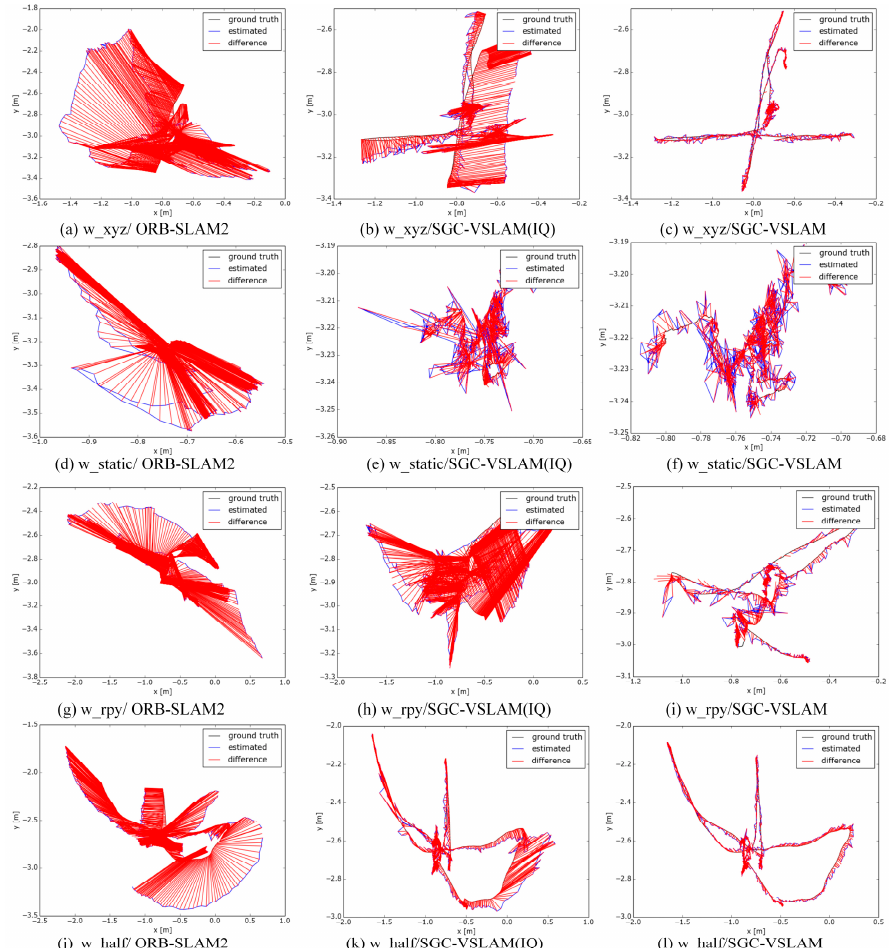
Figure 5. The SLAM trajectory in the high-dynamic sequence. Three systems were tested on the high dynamic sequences. The same row in the figure is the test results of the systems on the same test sequence. The first column in the figure represents the test results of ORB-SLAM2, the second column denotes SGC-VSLAM(IQ) and the third column is the test trajectory of SGC-VSLAM. Table 4. Comparisons of the relative RMSE [m] improvement for SGC-VSLAM against the state-of-the-art system for the dynamic sequence of the TUM RGB-D